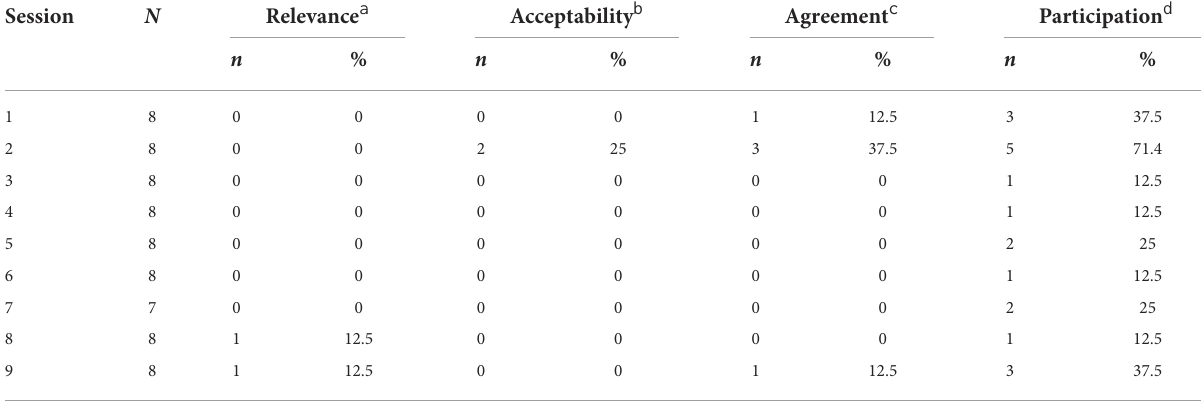
TABLE 7 Facilitator-rated perceived acceptability of the group sessions to caregivers.